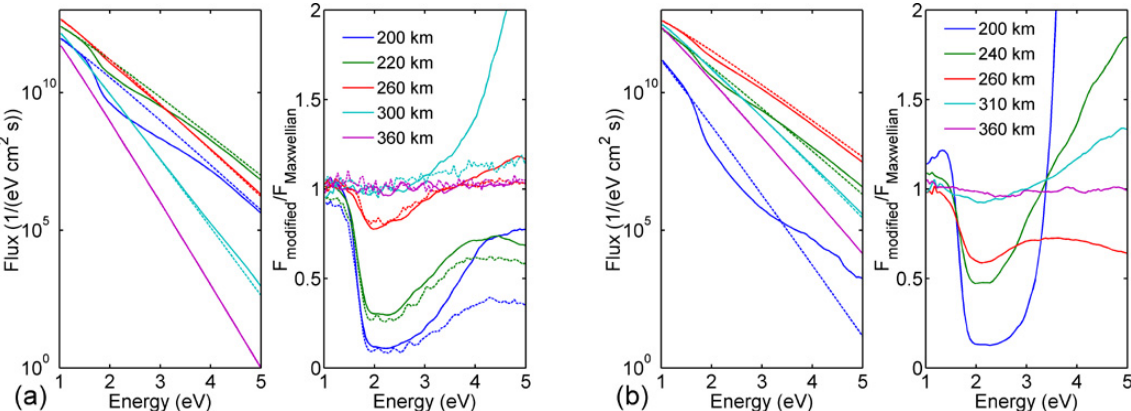
Fig. 3. (a) The differential flux (left) and ratio of the differential fluxes (right) at different altitudes for the heating pulse at 18:12UT. The dashed lines on the left plot show the corresponding Maxwellian fluxes. The dashed lines on the right plot show calculation results obtained without electron transport effects; (b) same as panel (a) for the heating pulse at 18:54UT.